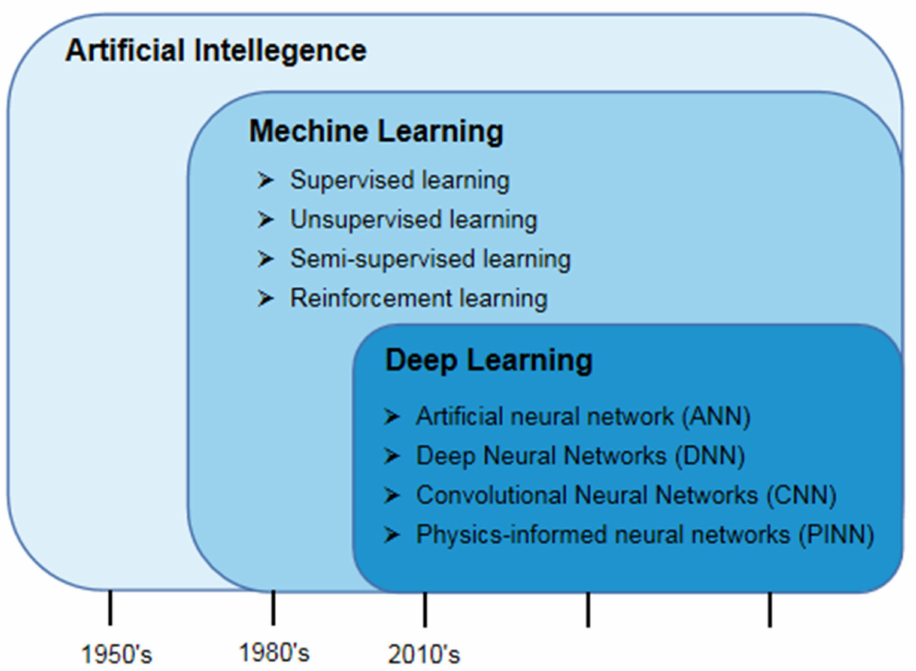
Figure 2. The overview development of artificial intelligence and the relationship between artificial intelligence, machine learning, and deep